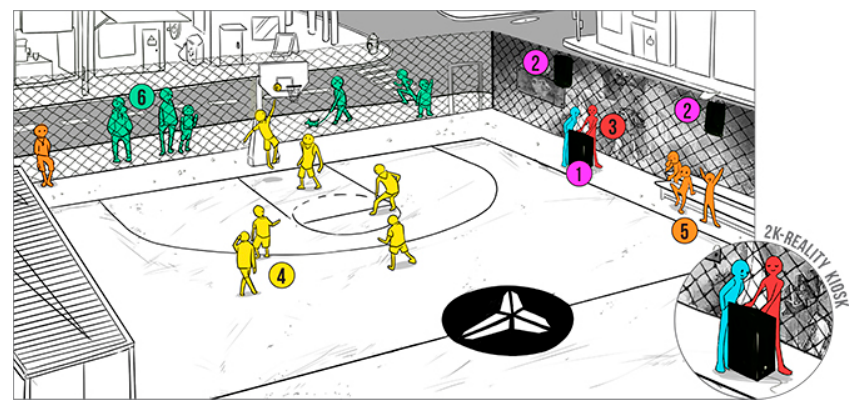
Figure 1. 2K-Reality urban basketball playspace scenario. Legend: 1. 2K-Reality tablet-based kiosk;